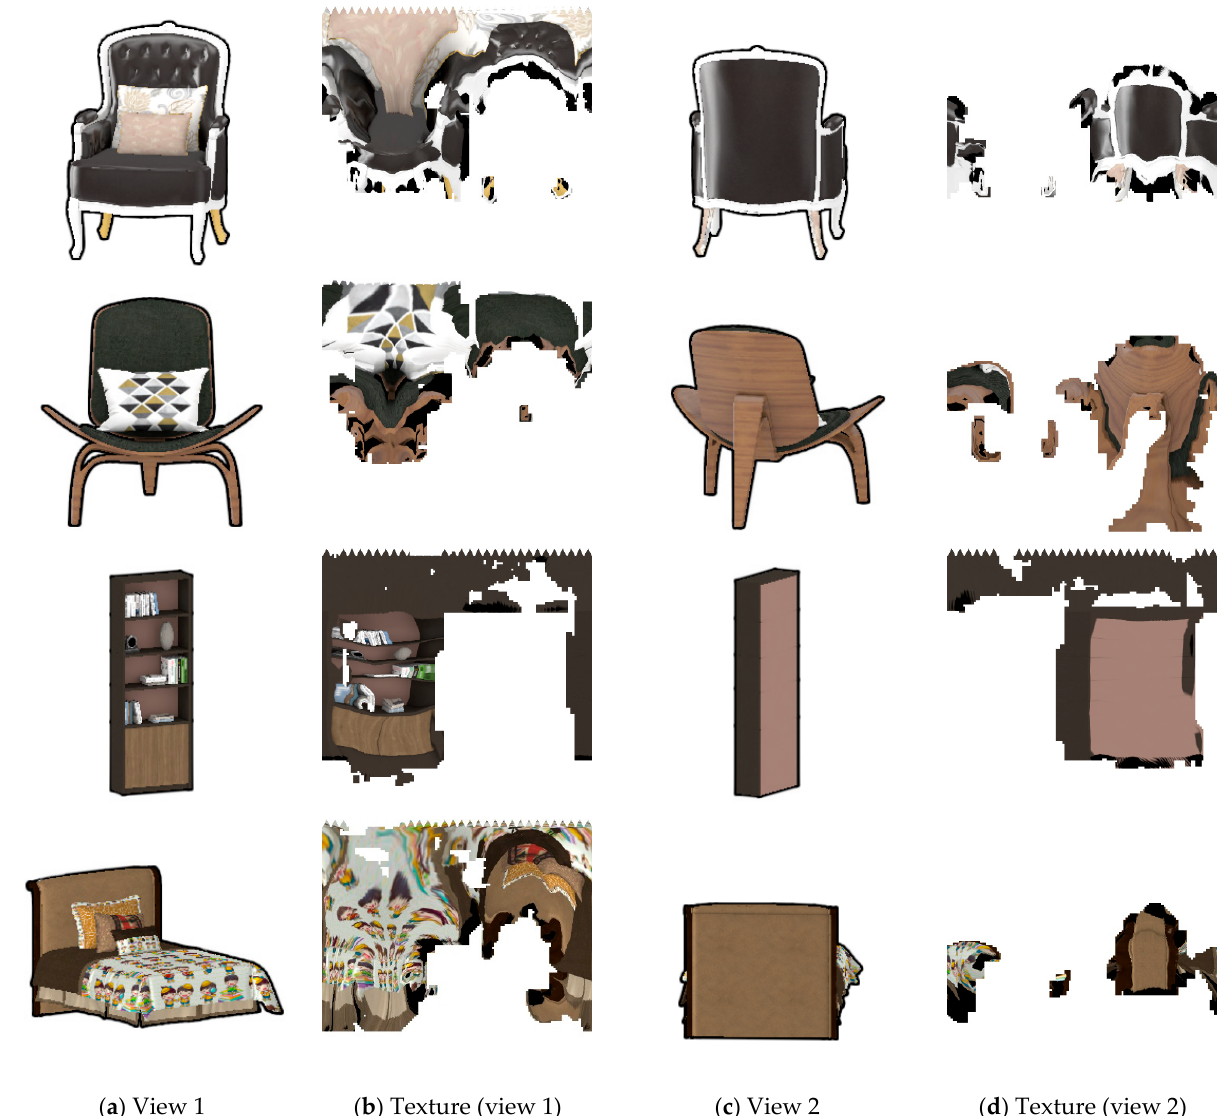
Figure 5. Generated ground truth rendered image and corresponding texture image. The ( a , c ) columns show the rendered image, the ( b , d ) columns show the corresponding texture images that are visible in column ( a , c ). Image and texture of each row belong to one 3D model.